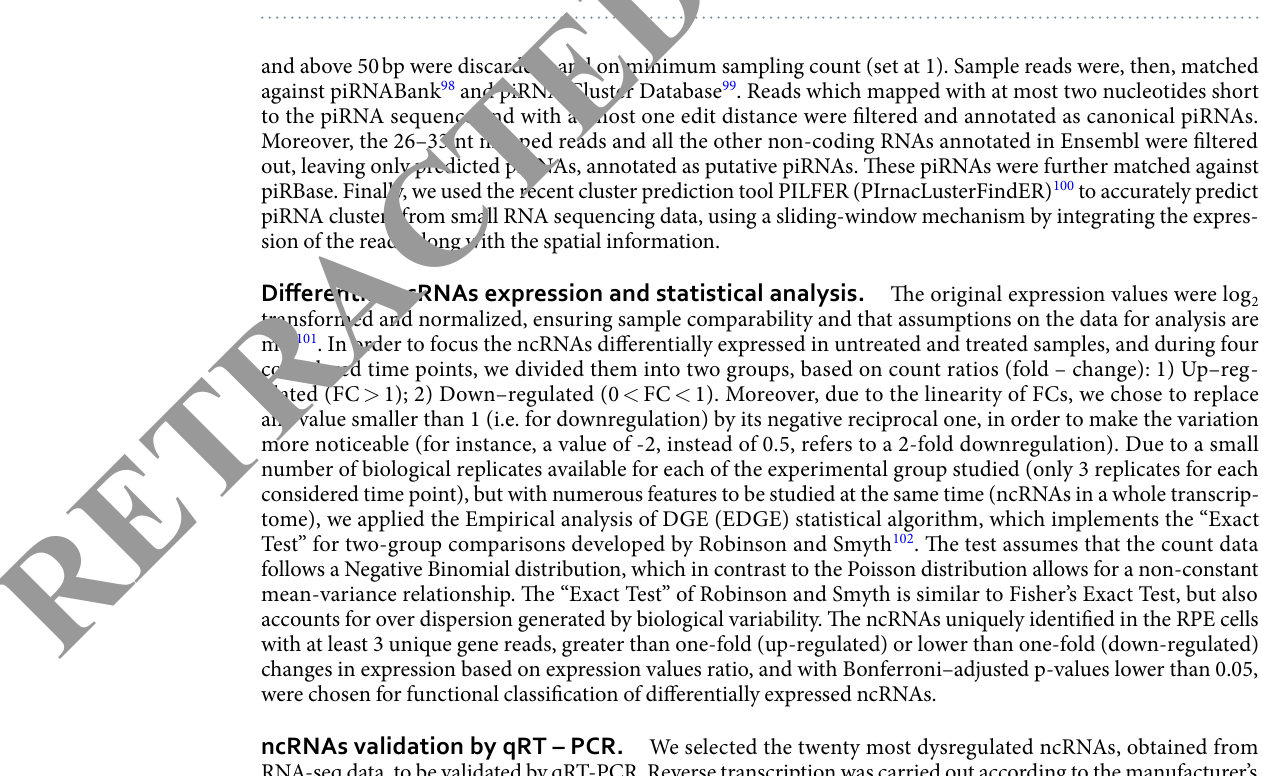
Figure 7. Data analysis specific pipelines for considered non–coding RNAs. Each investigated non – coding RNAs was analyzed by specific bioinformatic tools (red text), each one with its own selective pipelines for circular RNAs ( a ), PIWI–interacting RNAs ( b ) and long non–coding RNAs ( c